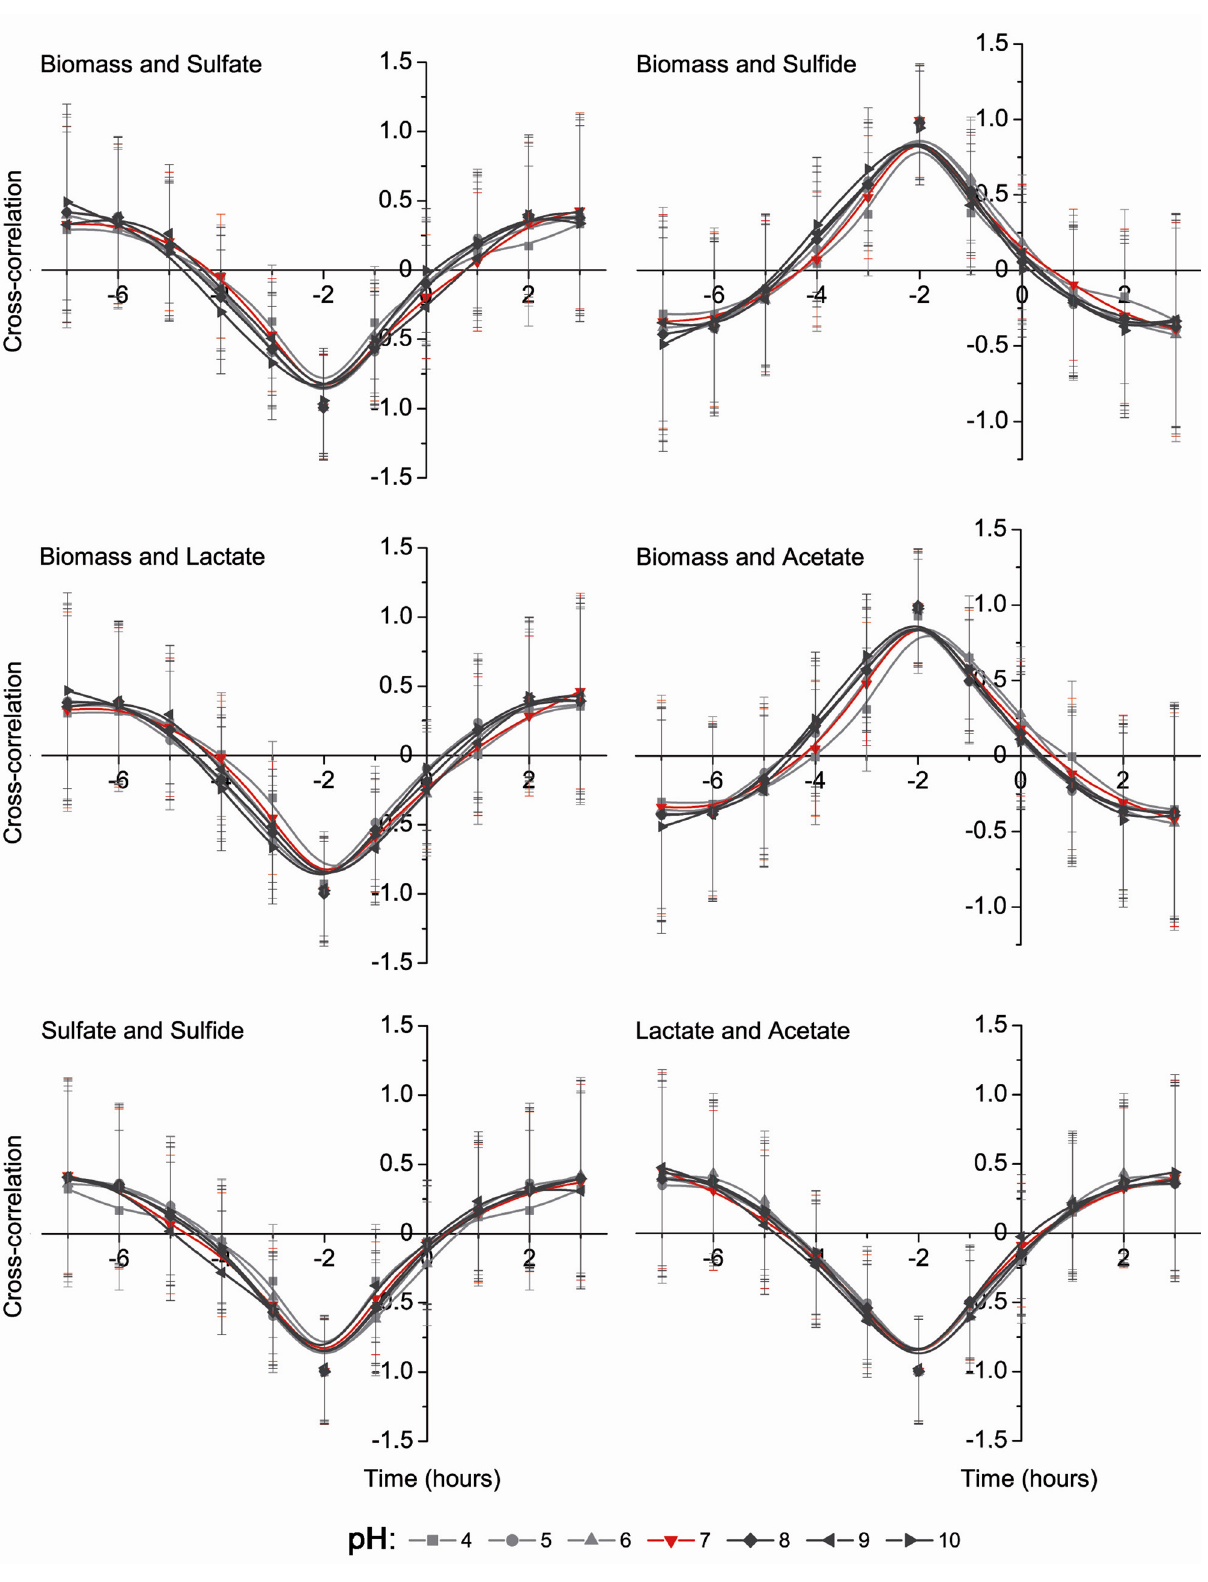
Figure 3: Cross-correlation analysis between biomass accumulation and sulfate consumption, sulfide production, lactate oxidation and acetate accumulation as well as between sulfate and sulfide, same as between lactate and